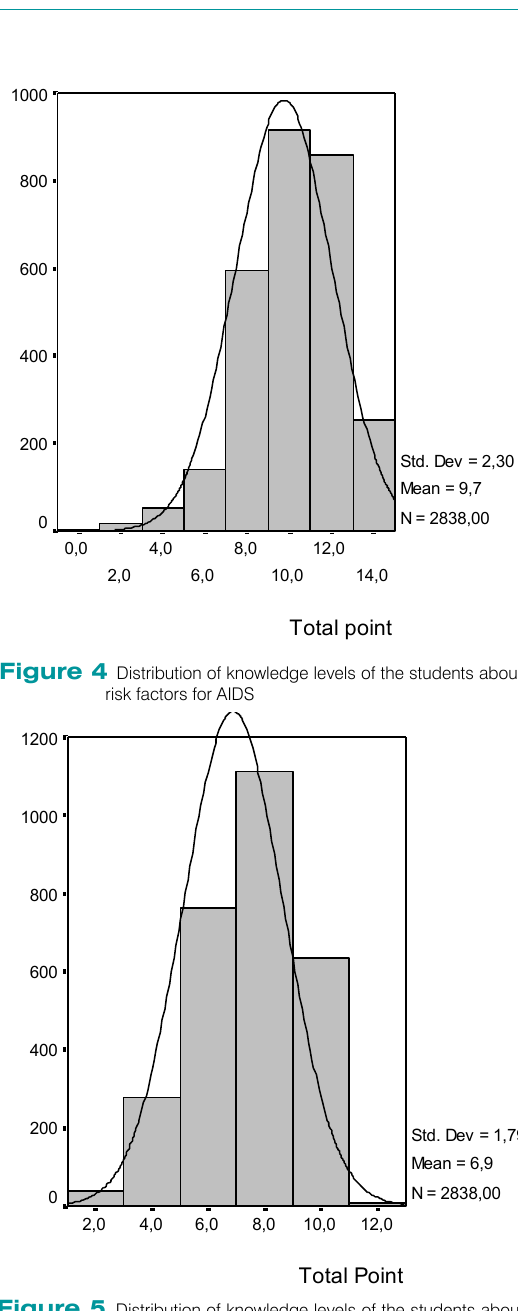
Figure 5 Distribution of knowledge levels of the students about the protection ways from